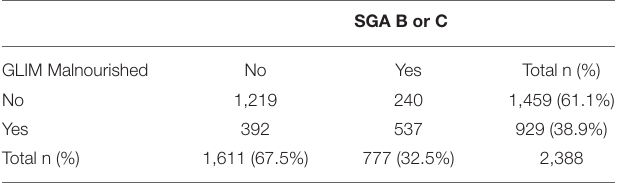
TABLE 4 | Number of patients with cancer identified as malnourished by SGA and GLIM.